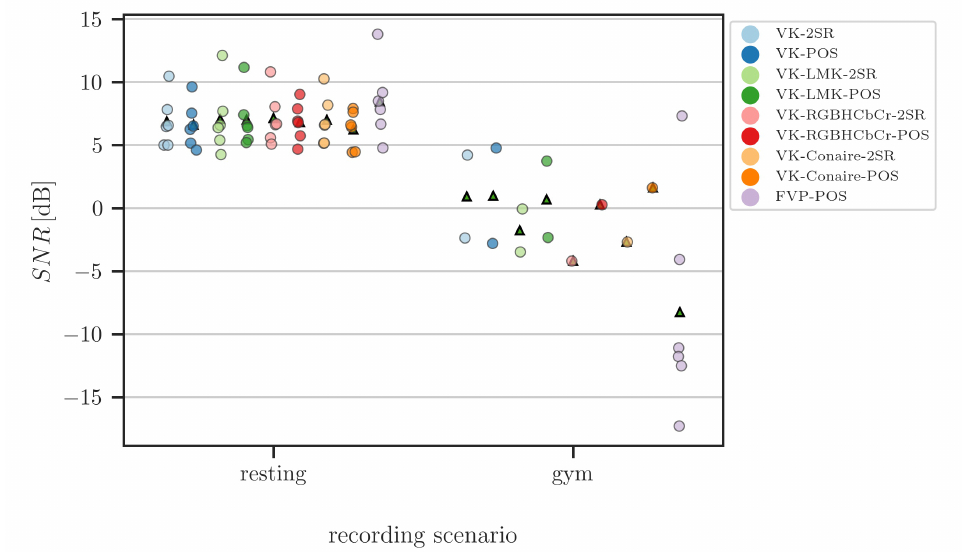
Figure 4. Performance of the studied approaches with and without image processing front-end in combination with two rPPG algorithms (POS and 2SR) in terms of SNR on the example of LGI–PPGI–FVD. VK: Viola-Jones combined with ROI width reduction and Kanade–Lucas–Tomasi tracker; VK-Conaire: Viola-Jones combined with skin detector based on the maximization of mutual information and Kanade–Lucas–Tomasi tracker; VK-LMK: Viola-Jones combined with landmarks detection and Kanade–Lucas–Tomasi tracker; VK-RGBHCbCr: Viola-Jones combined with RGB–H– CbCr skin-color segmentation and Kanade–Lucas–Tomasi tracker; FVP: Full Video Pulse Extraction rPPG